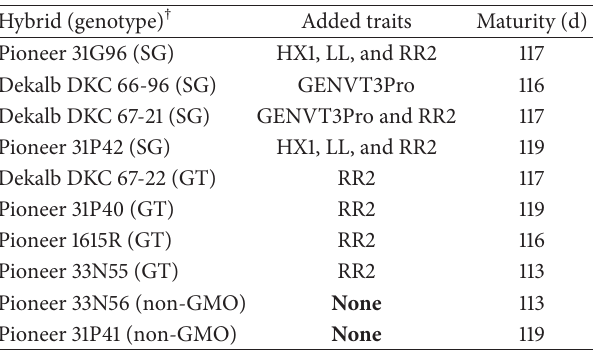
Table1:Maizehybrids,theirgenotype(stackedgene,SG;glyphosate tolerant, GT; non-GMO), and maturity rating (d) grown under furrow irrigation at two sites, a Bosket fine sandy loam and a Tunica clay soil at Stoneville, MS, in 2011 and